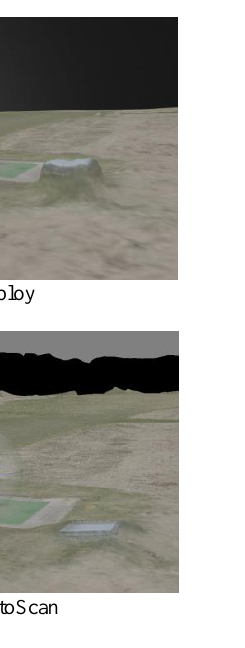
Figure 6. 3D models generated for man-made structure